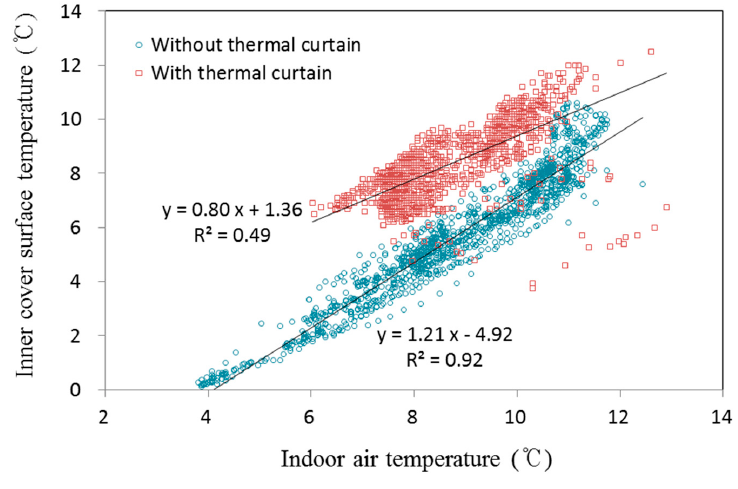
Figure 5. Inner cover surface temperature as a function of indoor air temperature without and with thermal curtains.